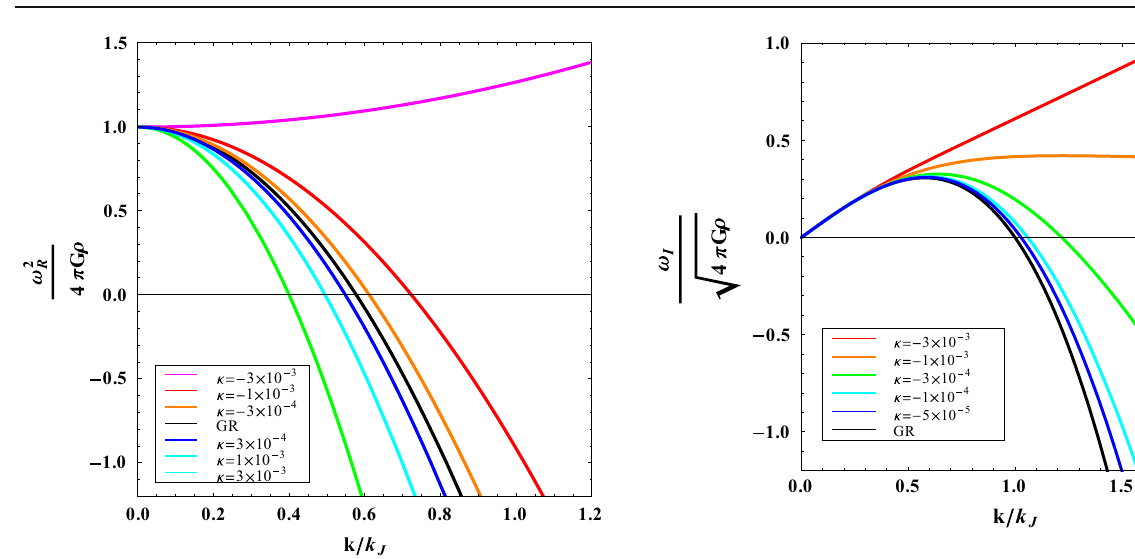
< ρ ∗ in a star 0 0